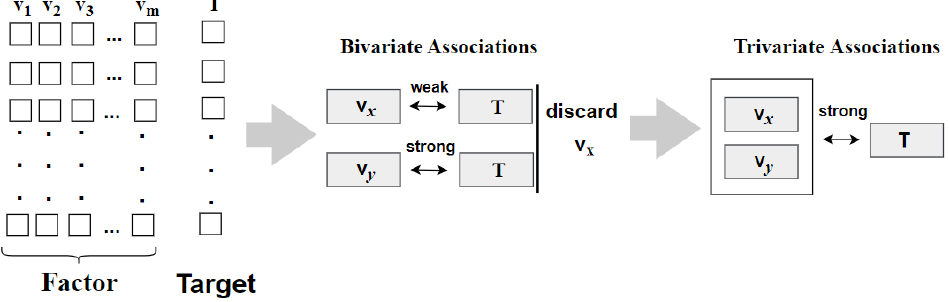
Figure 1. Advantages of trivariate associations analysis.